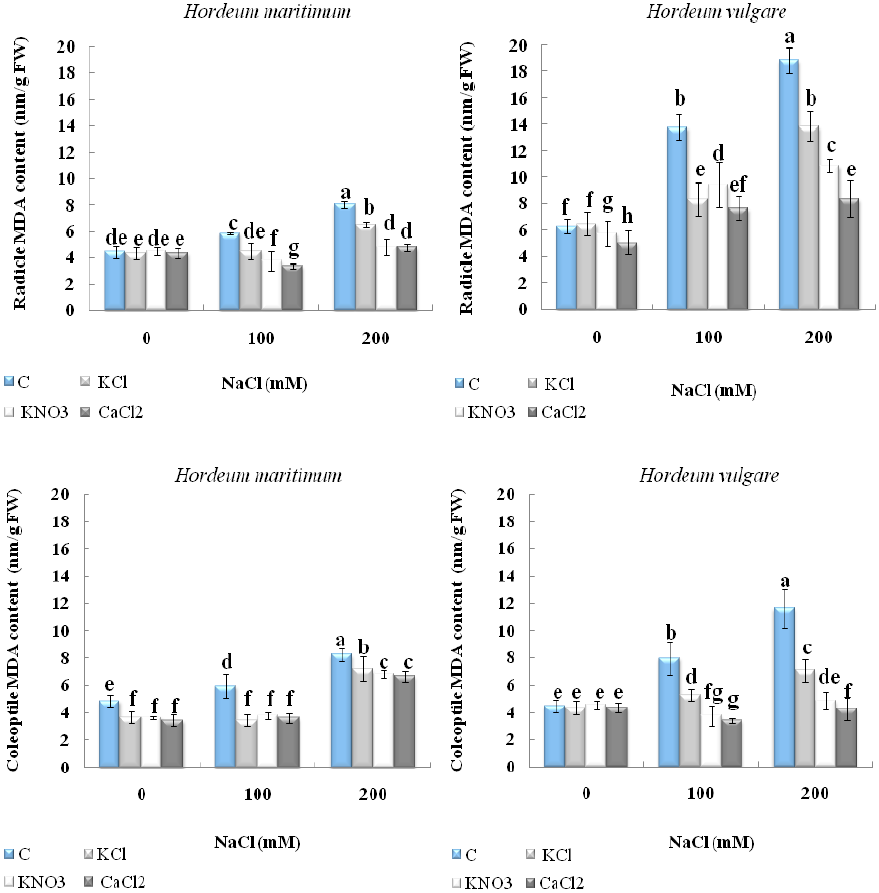
Figure 6. Effect of KCl, KNO 3 , and CaCl 2 seed priming on the malondialdehyde content (MDA) on the radicle and coleoptile of two barley species, Hordeum maritimum and Hordeum vulgare (L. Manel), subjected to various salt concentrations (0, 100, and 200 mM NaCl) for 7 days at the germination stage. Values are means of 5 independent replicates ± standard error. Data with the same letter are not significantly different at p < 0.05 (Duncan’s test).